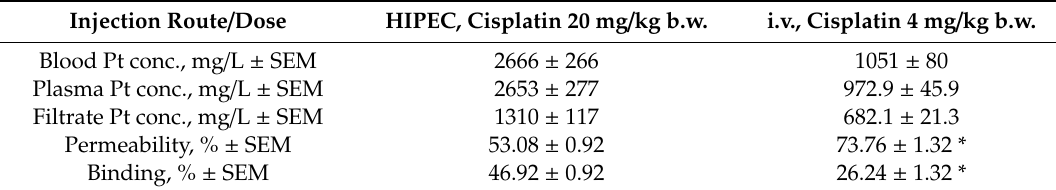
Table 2. The concentrations of “free” (10 kDa ultrafiltrable) platinum after HIPEC and i.v. injections of cisplatin in rats 15 min after the injection. Calculated as average for three rats ( n = 3). Injection Route/Dose HIPEC, Cisplatin 20 mg/kg b.w.